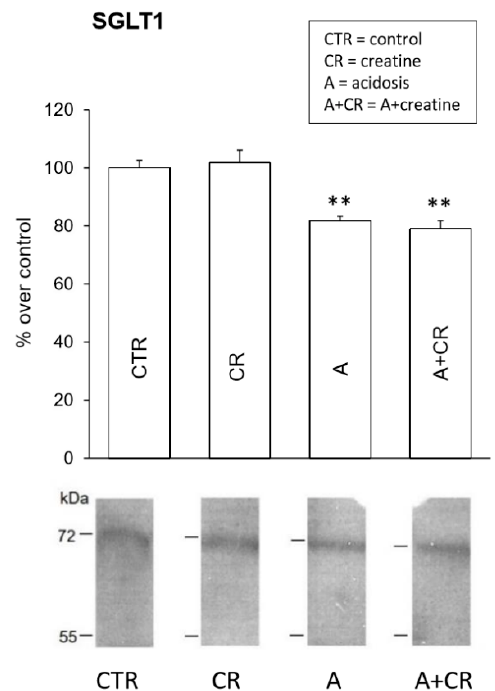
Figure 8. Effects of 11 d administration of 20 mM creatine on sodium-glucose transporter 1 (SGLT1) expression in jejunal mucosal homogenates under control conditions and chronic acidosis. Western blot analysis for SGLT1 was performed on jejunum total proteins and was carried out on 4 experiments. Densitometric analysis of the bands revealed a significant statistical difference in the intensity of the signals. ** p ≤ 0.05 vs. control.